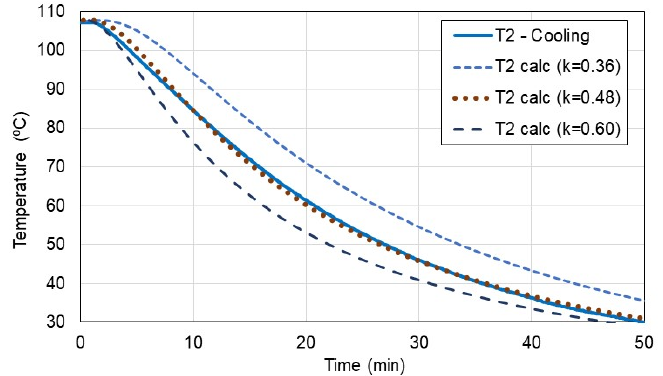
Figure 5. Normalized temperature for heating and cooling tests.